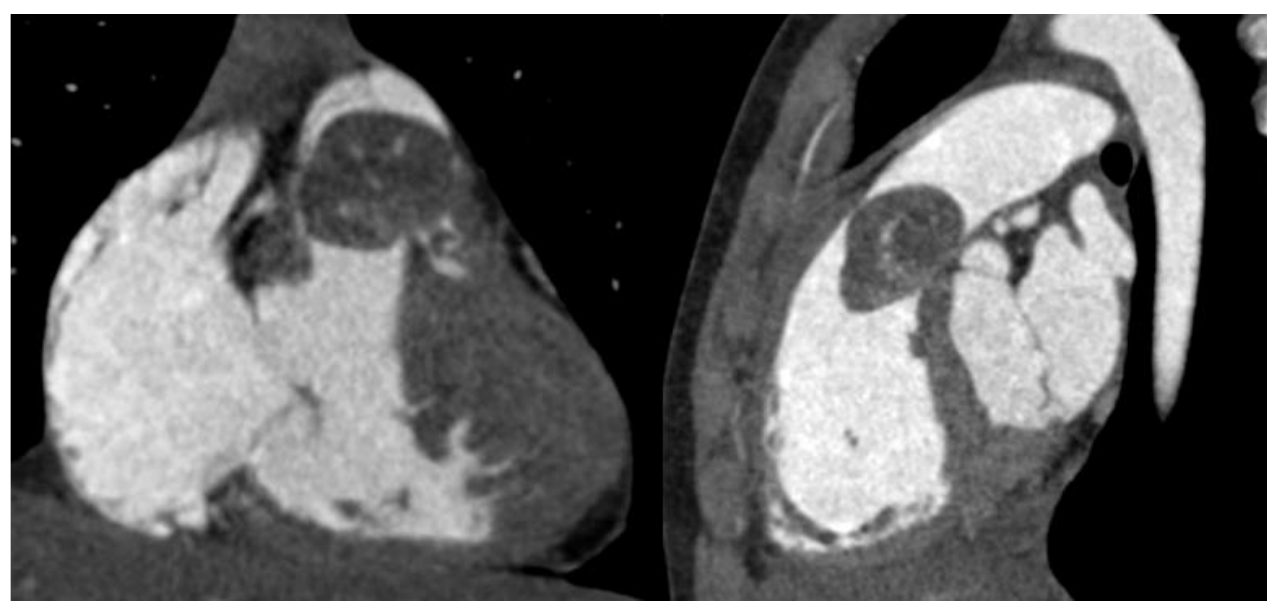
Figure 3. Color Doppler transesophageal echocardiography.